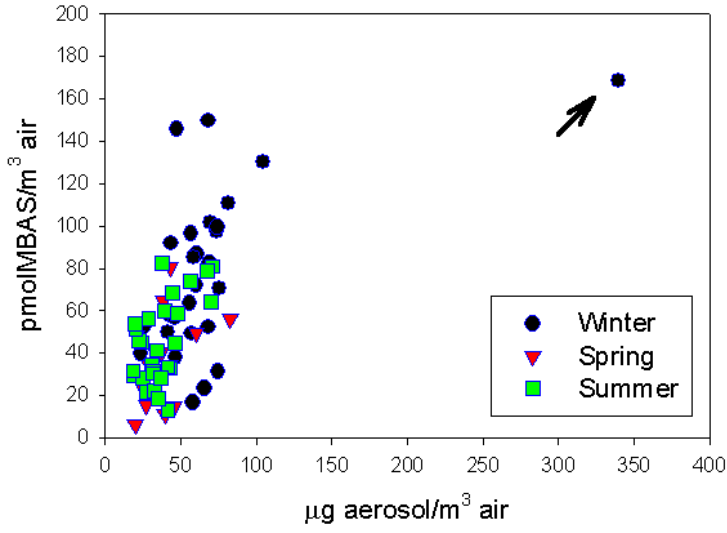
FIGURE 1. Methylene blue active substances (MBAS) concentration in the atmosphere as a function of aerosol loading. Arrow indicates day of perceptible local pollution from domestic fireplaces.